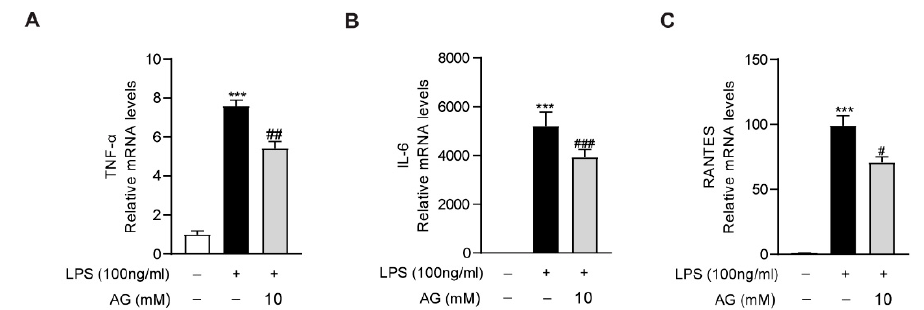
Figure 7. Impact of Ala ‐ Gln on LPS ‐ induced inflammatory responses in RAW264.7 cells. ( A – C ) mRNA expression levels of TNF ‐α , IL ‐ 6, and RANTES in RAW264.7 cells. Data are expressed as mean ± SD. *** p < 0.001 vs. vehicle ‐ treated control group, # p < 0.05, ## p < 0.01, ### p < 0.001 vs. LPS ‐ treated model group.